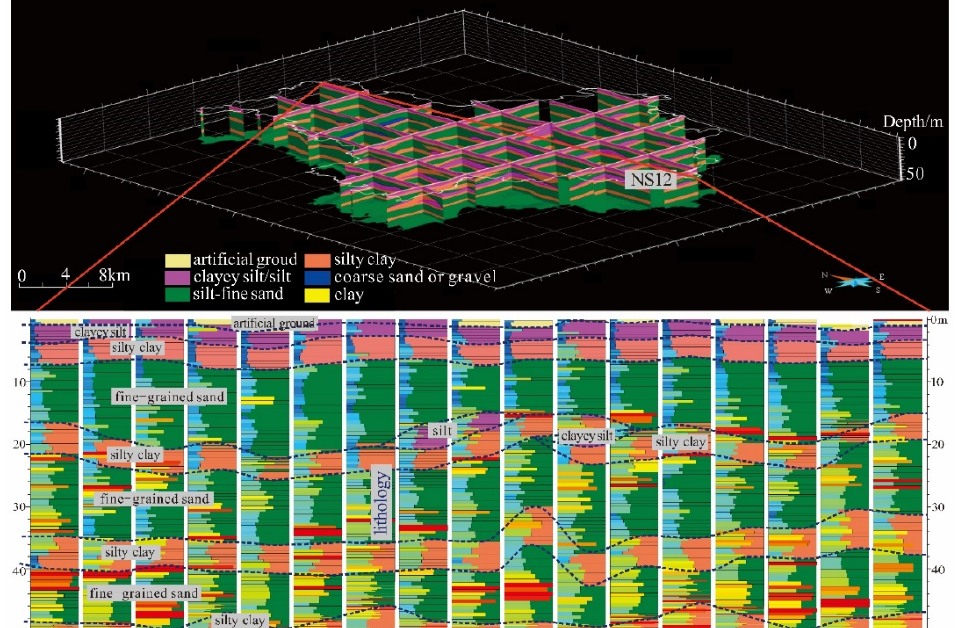
Figure 10. Layer distributions based on the 3D geological model. Upper: fence diagrams of the model; below: layer distributions along the NS12 cross-section.